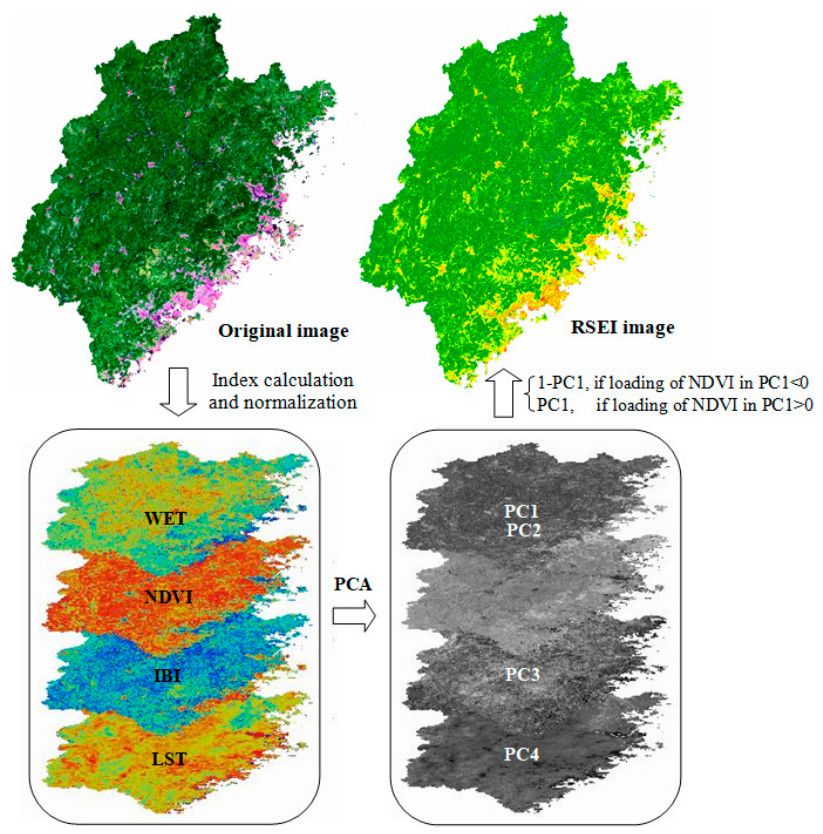
Figure 2. Sketch showing the processing for remote sensing based ecological index (RSEI).